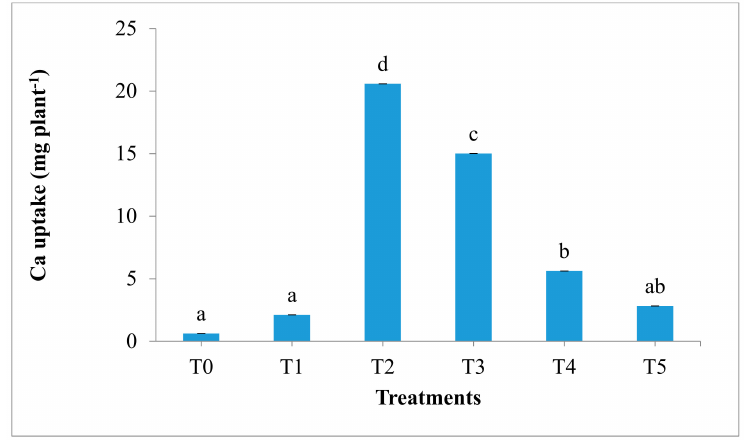
Figure 7. Effects of treatments on total Ca uptake at harvest (70 DAT). Mean values with different letter(s) indicate significant difference between treatments by Tukey’s test at p ≤ 0.05. Bars represent the mean values ± SE.